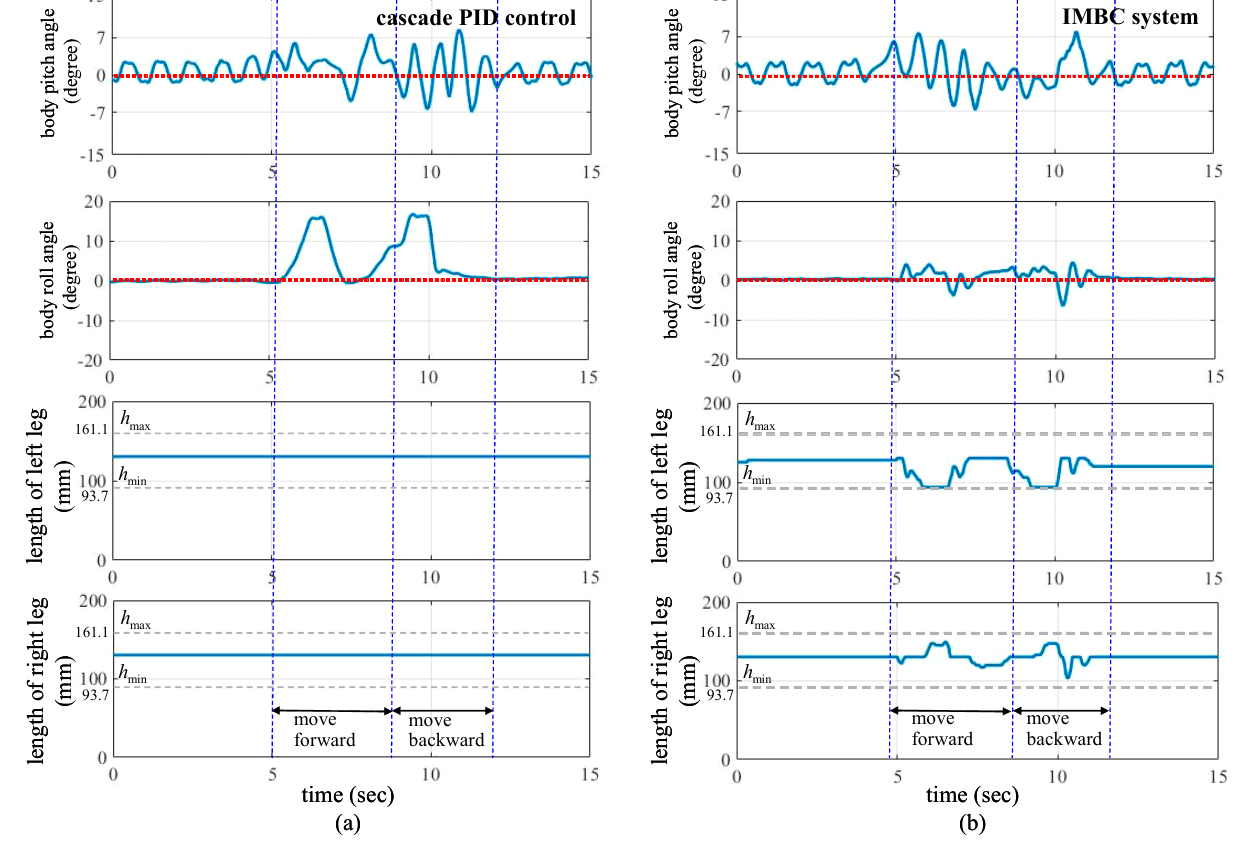
Figure 10. Results of one leg on slope moving. ( a ) Cascade PID control; ( b ) the IMBC system.